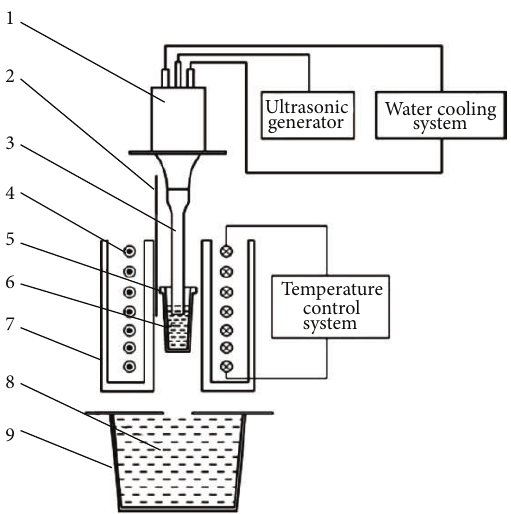
Figure 24: Schematic diagrams of the ultrasonic vibration device: (1) ultrasonic transducer; (2) thermocouple; (3) ultrasonic radiator; (4) resistance heater; (5) iron crucible; (6) Mg-9.0Al%; (7) ceramic tube; (8) water; (9) tank [52].